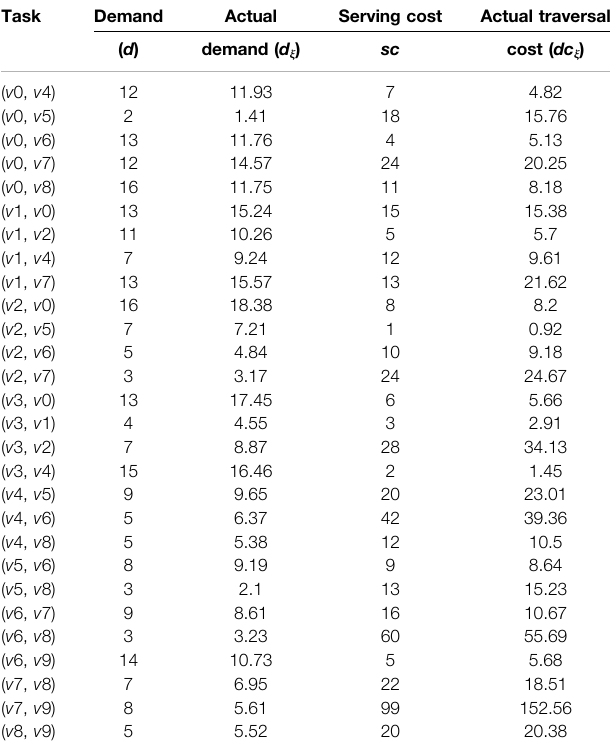
TABLE 5 | The detailed information of one instance of ugdb 13.